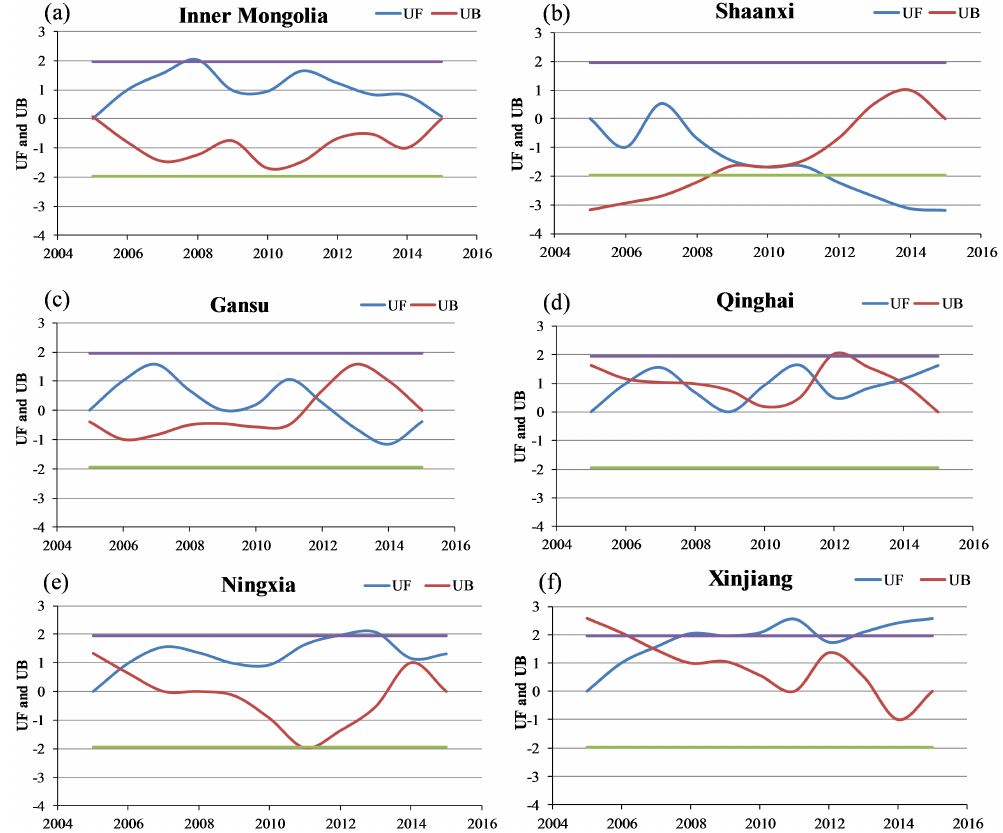
Figure 9. Same as Fig. 6 but for Mann–Kendall (MK) test statistics for annually averaged SO 2 VCD in six provinces in northwestern China from 2005 to